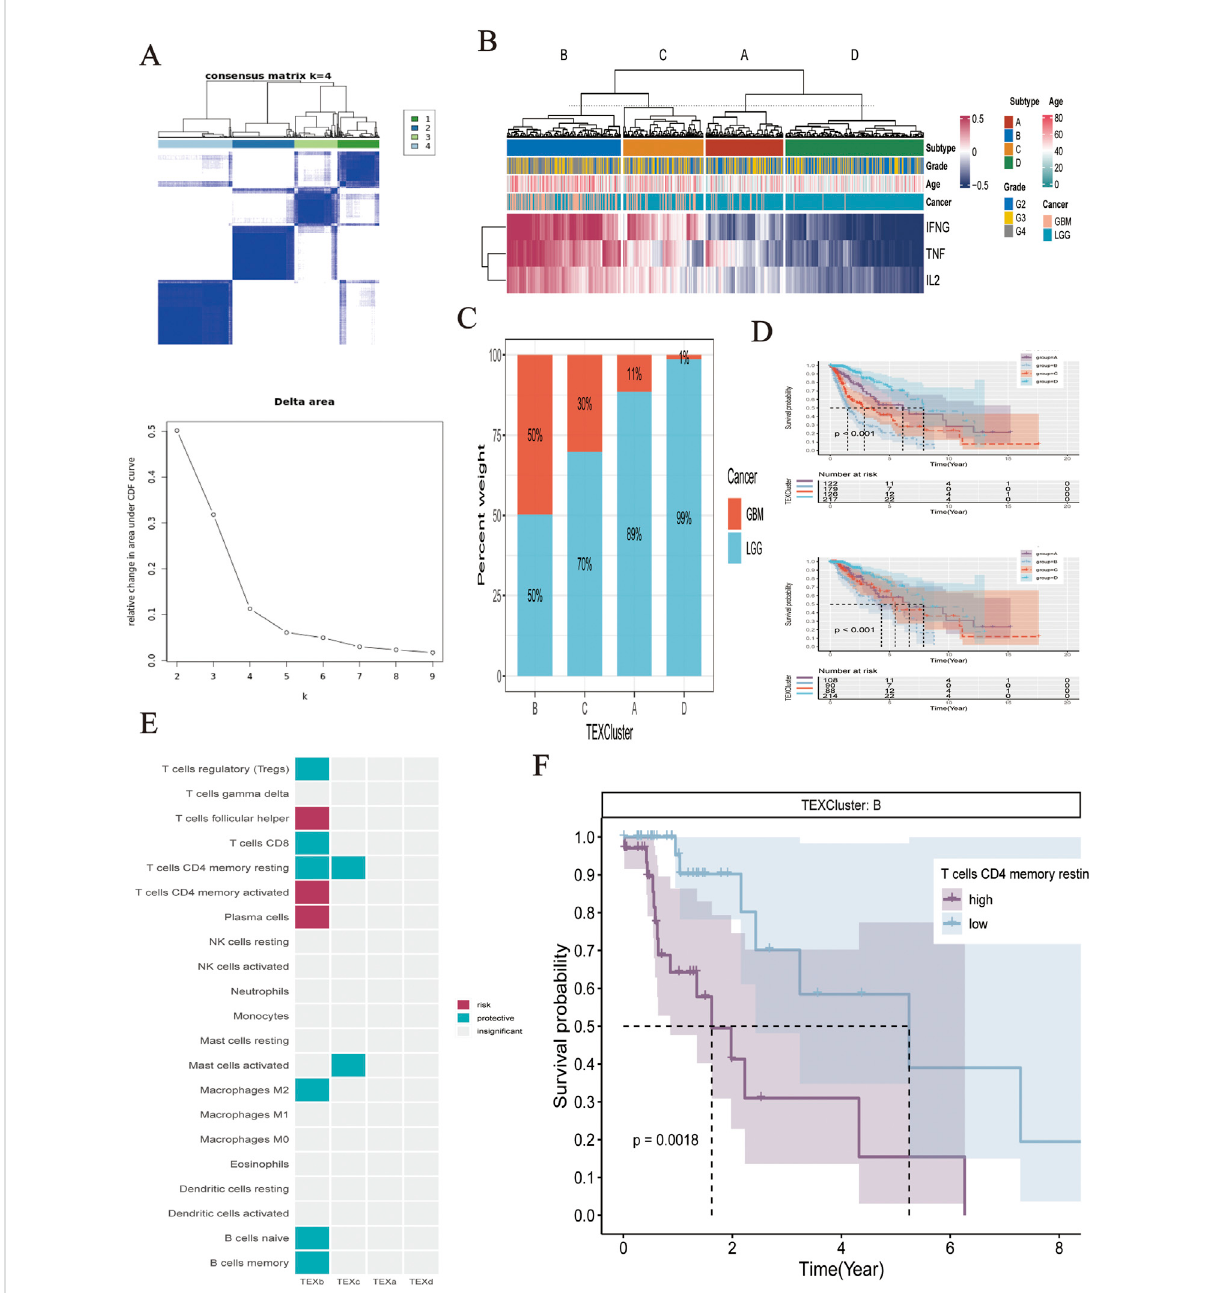
FIGURE 1 (A) Unsupervised clustering classi fi cation. (B) Heatmap showed the expression of IL2/IFNG/TNFA pathway in different subtypes and clinical pathology. (C) Bar chart showed the proportion of LGG and GBM in different molecular subtypes. (D) K-M analysis of four subtypes. (E) The effect